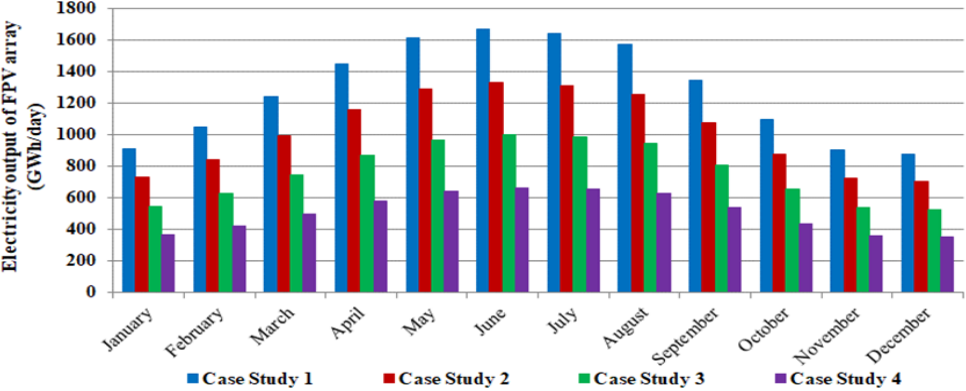
Figure 8. Daily electricity generation of a floating photovoltaic array installed on Lake Nasser . The results presented previously showed that covering Lake Nasser with floating photovoltaic panels represents a very effective solution for Egypt, which suffers from water poverty in addition to electric power. As shown in Table 4, the annual rates of electric- ity production from the floating photovoltaic system of Lake Nasser depended on the percentage of the area covered by the floating photovoltaic panels. The annual rate of elec- tricity production from the FPV panels system for Lake Nasser reached 467.99 TWh/year, 374.41 TWh/year, 280.787 TWh/year, and 187.21 TWh/year when covering 50% (Case Study 1), 40% (Case Study 2), 30% (Case Study 3), and 20% (Case Study 4) of Lake Nasser with FPV panels, Table 4. Floating photovoltaic (FPV) panels generation results.